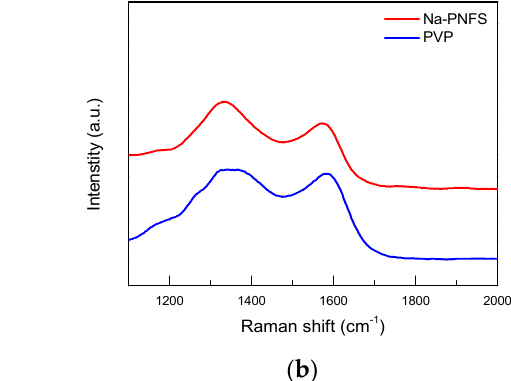
Figure 8. Raman spectrum of Cu@MC. The critical micelle concentration of the Na-PNFS was 1.69 mmol/L [25]. Therefore, when the Na-PNFS was added at a concentration of 5 g/L (or 2.5 mmol/L), as in the exper- iment, micelles were formed in the solution. With the presence of PVP, the micelles could interact with PVP to form polymer–surfactant complexes [26]. The copper nanocrystalline was formed inside the micelles, and then clustered as larger particles with the help of complexes, and eventually transformed into carbonated shells after annealing [27,28]. Thermogravimetric analysis (TGA) tests of Na-PNFS and PVP show that Na-PNFS have a 60% weight remaining at 800 ◦ C PVP, while PVP is almost completely decomposed with only 2.3% remaining at 750 ◦ C (Figure 9a). The Raman spectra of Na-PNFS and PVP annealing at 900 ◦ C for 2 h in a nitrogen atmosphere show that the residues were graphitized materials (Figure 9b). This result indicates that the carbon layer on the copper surface was mainly derived from Na-PNFS, which was the soft template when Cu NPs were formed.